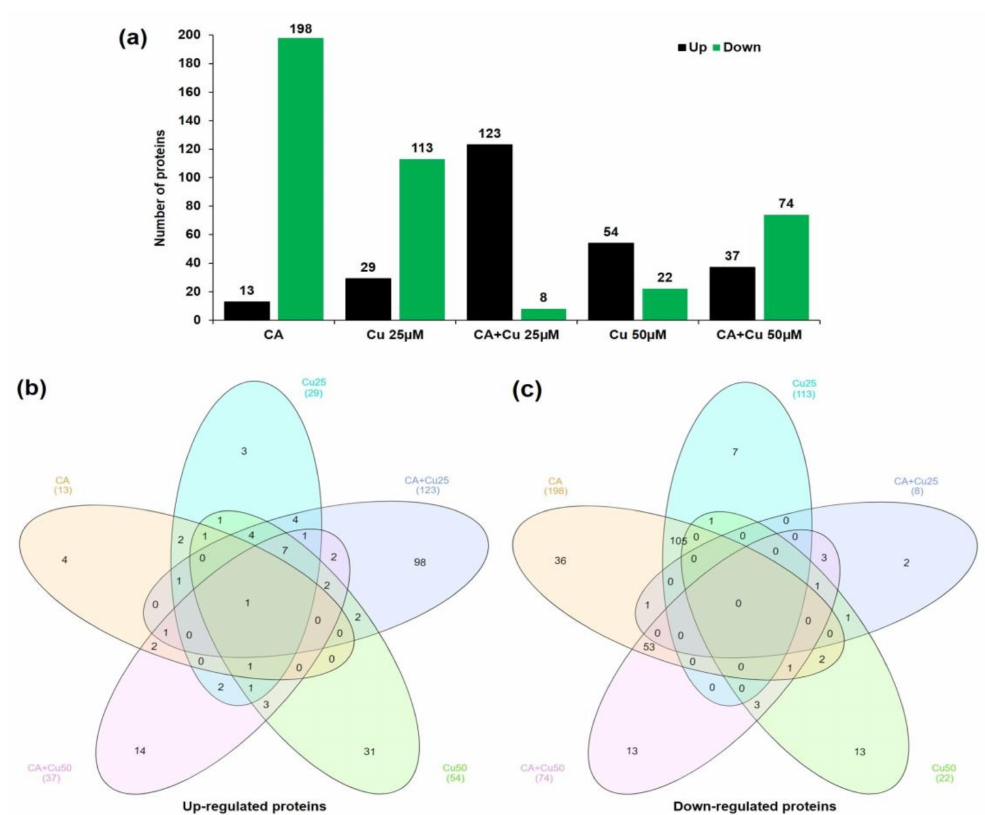
Figure 4. Identification and statistics analysis of DAPs under different treatment groups. ( a ) Number of up- or downregu- lated proteins between the CK group and different treatments. ( b ) Venn diagram analyses for upregulated proteins. ( c ) Venn diagram analysis for downregulated